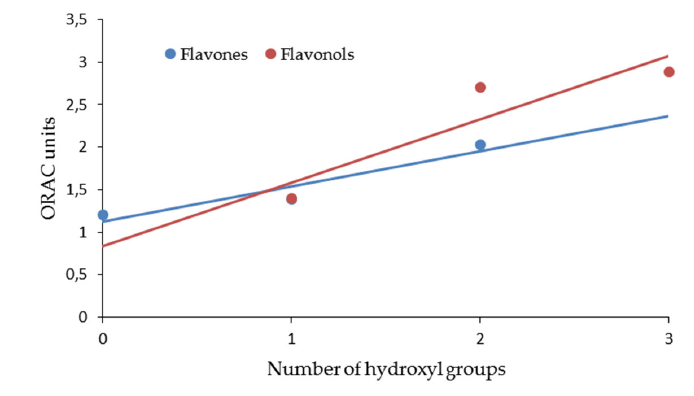
Figure 2. Relationships between ORAC (oxygen radical absorbance capacity) values and the number of hydroxyl groups in the flavone and flavonol molecules.